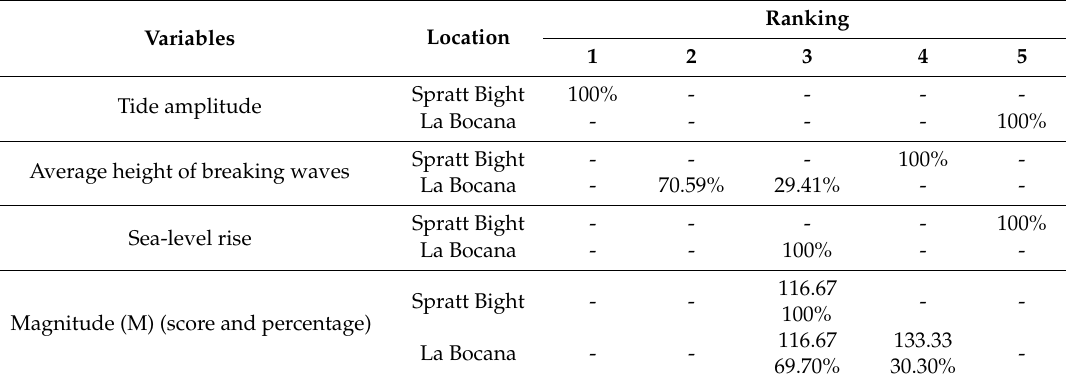
Table 4. Results of the magnitude component of the hazard by coastal erosion, study area, ranking, and final score obtained. The percentage represents the number of segments on each ranking over the total number of segments.